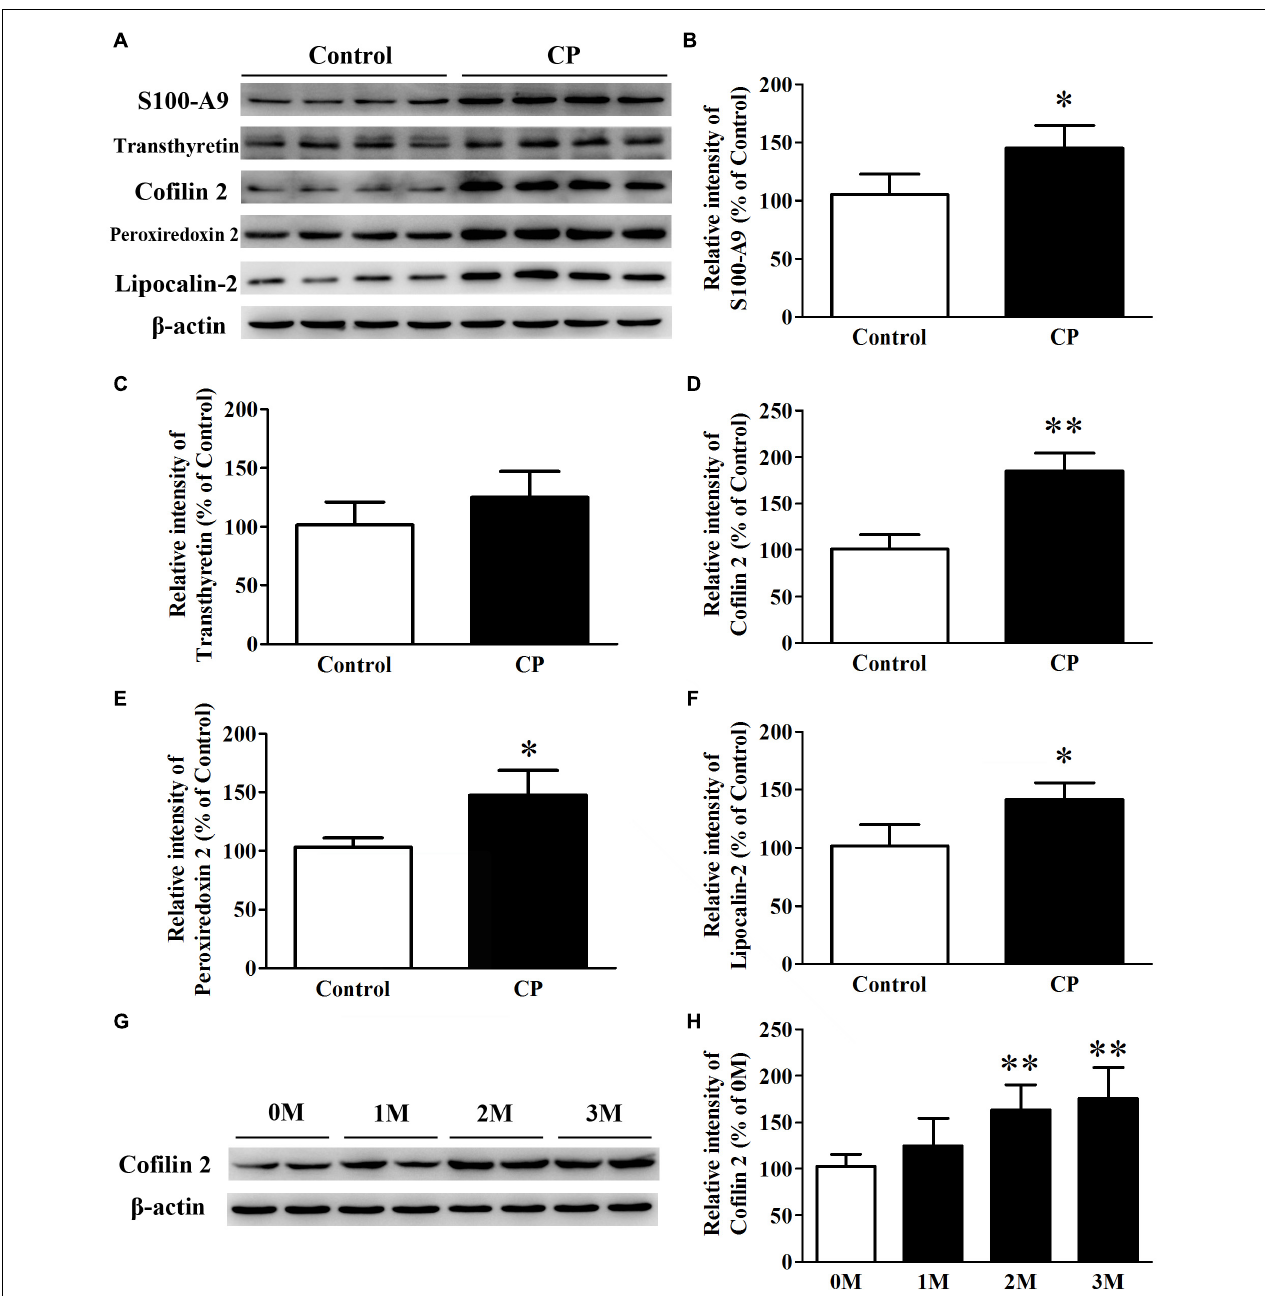
FIGURE 3 | Expression of S100-A9, transthyretin, Cofilin 2, peroxiredoxin 2 and lipocalin-2 in the hippocampus of CP, and control mice. (A) Representative panel of Western blots of S100-A9, transthyretin, Cofilin 2, peroxiredoxin 2, and lipocalin-2. (B) Quantitative comparison of the Western blot of S100-A9. (C) Quantitative comparison of the Western blot of transthyretin. (D) Quantitative comparison of the Western blot of Cofilin 2. (E) Quantitative comparison of the Western blot of peroxiredoxin 2. (F) Quantitative comparison of the Western blot of lipocalin-2. (G) Representative panel of Western blots of Cofilin 2 in the time course of CP. (H) Quantitative comparison of the Western blot of Cofilin 2 in the time course of CP. Data represent mean ± SD for 8 mice per group. ∗ p < 0.05 vs. control group; ∗∗ p < 0.01 compared with 0M.